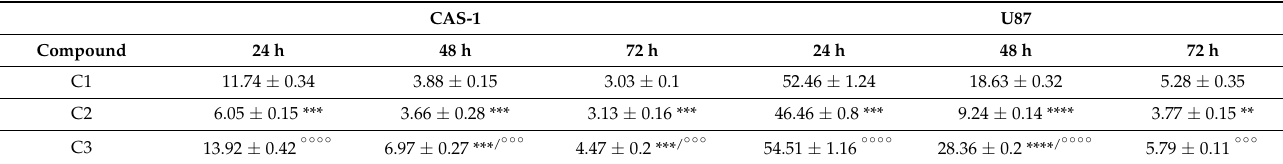
Table 1. IC 50 evaluated in CAS-1 and U87 cell lines treated with increasing doses (1–10 µ M) of C1 (SI306), C2, and C3 for 24, 48, and 72 h. The data are the means ± S.E.M. of five indepen- dent experiments. Statistical significance of differences was determined by ANOVA followed by Tukey’s test. ** p < 0.01 vs. C1; *** p < 0.001 vs. C1; **** p < 0.0001 vs. C1; ◦◦◦ p < 0.001 vs. C2; and ◦◦◦◦ p < 0.0001 vs.